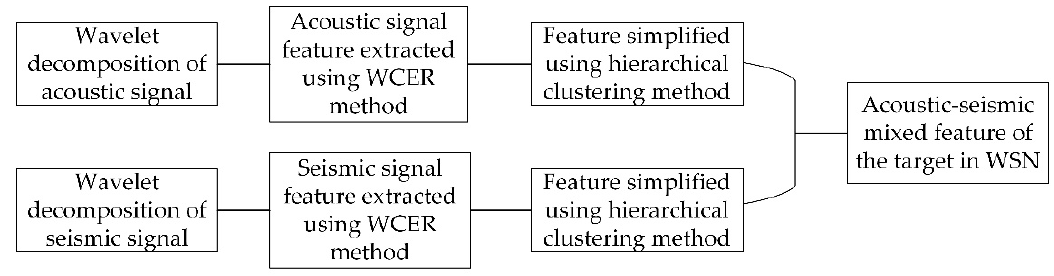
Figure 7. Flowchart of the acoustic–seismic mixed feature extraction method based on WCER.